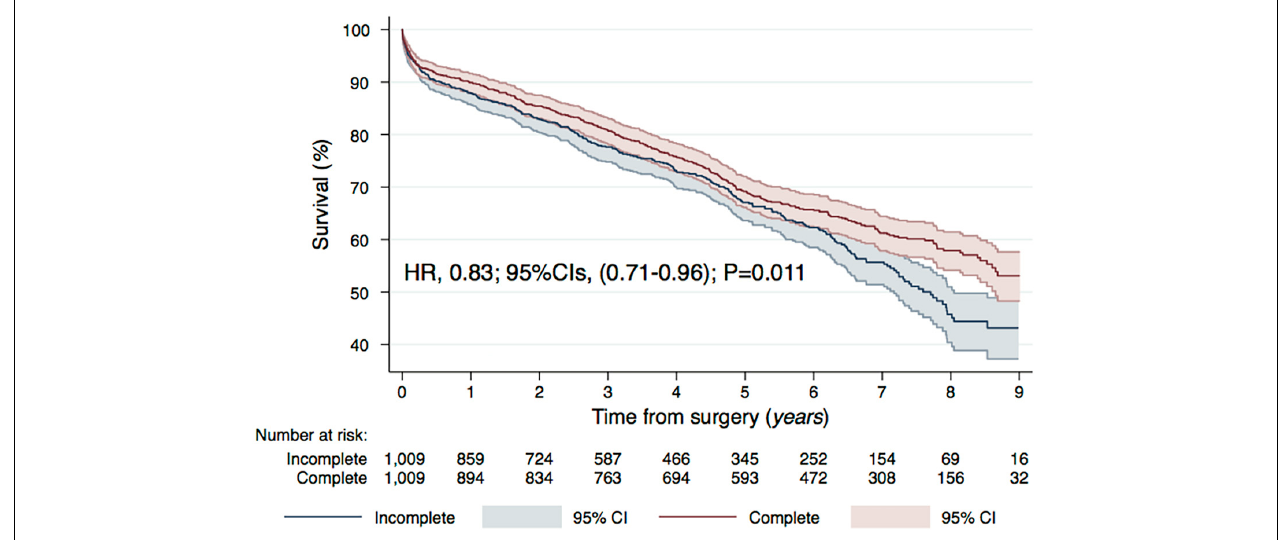
FIGURE 2 | Long-term mortality, propensity matched Kaplan–Meier survival curves between the two groups: CR vs. non-CR CABG for the analysis of long-term survival. Hazard Ratios and respective 95% Confidence Intervals.